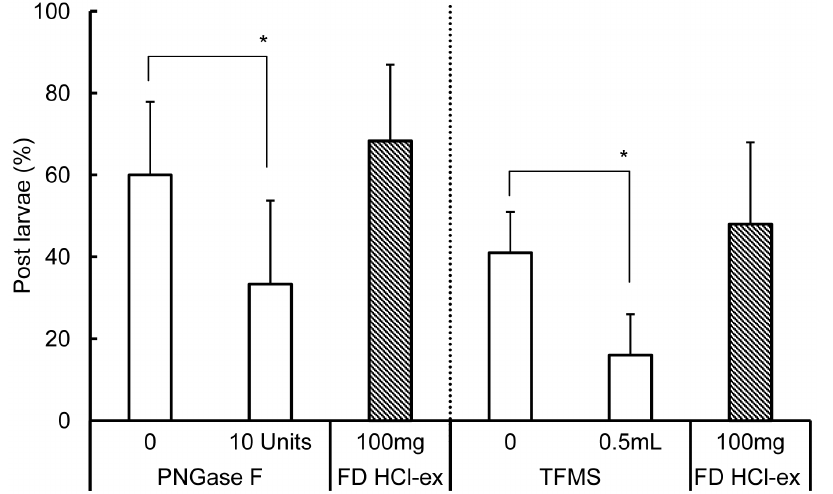
Figure 7. Percentages of post larvae on PNGase F and TFMS treated FD HCl-ex of C.gigas SC. Boxes with slanting lines indicate post larvae (%) settled on FD HCl-ex 100 mg SC eq subjected to the same treatment procedure but without trypsin. Data are means of 9 replicates and error bars represent standard deviations (SD). Lines connected groups that were compared using Wald test. Asterisks * indicate significantly different groups (p , 0.05).